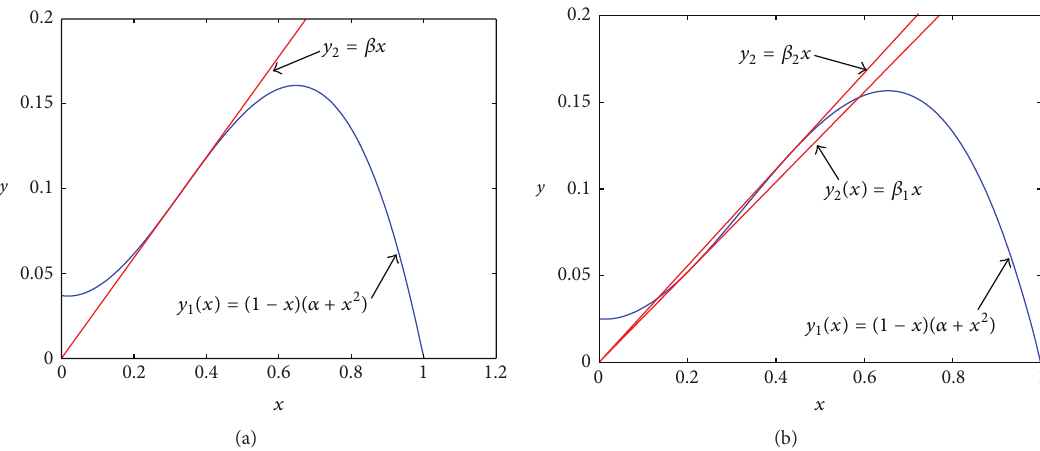
Figure 1: Diagram of positive equilibrium. (a) When 𝛼 ≥ 1/27 , there exists only one positive equilibrium for any 𝛽 > 0 . Here, 𝛼 = 1/27 , and 𝛽 = 8/27 . (b) When 0 < 𝛼 < 1/27 , there are three cases: (i) only one positive equilibrium for 𝛽 < 𝛽 𝛽 = 𝛽 𝛽 = 𝛽 1 or 2 , and (iii) three positive equilibria for